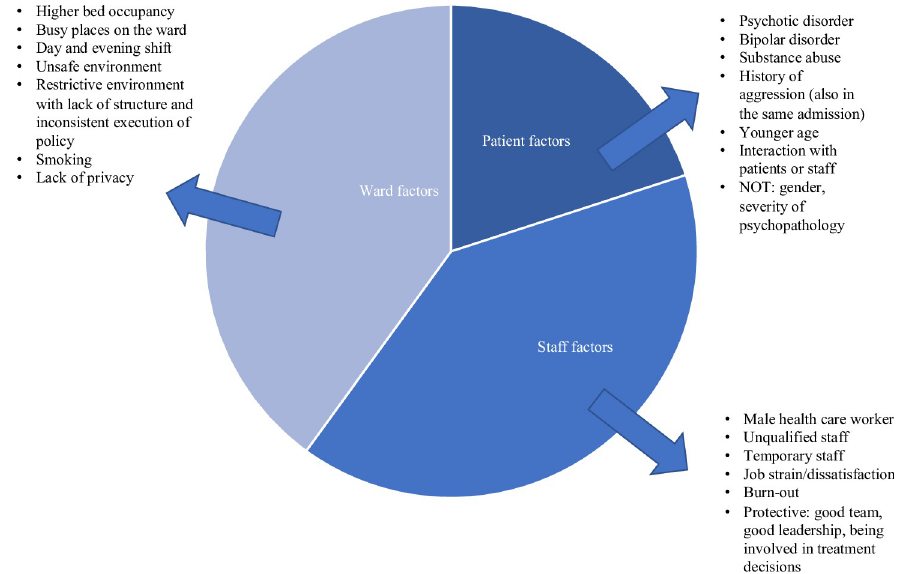
Fig 2. The contribution of the different factors to the development of